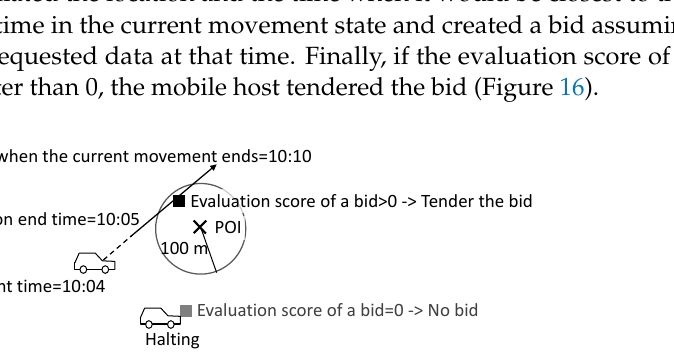
19 of 25 Figure 15. Simulation model for vehicle case (communication and mobility). 5.2.2. Mobility Model Mobile hosts moved by RWP, and they repeatedly stopped for a random period and moved to a randomly selected destination at a randomly selected velocity (Figure 15). The period for which a mobile host stops was selected to be between 0 s and 5.0 s by a uniform random number. The destination of a mobile host was selected by a uniform random num- ber. The density of the mobile hosts within the movement area varied from location to location, even in this scenario [26 – 28]. We used different velocity ranges for the pedestrian and vehicle cases. For the pedestrian case, the host velocity was between 0.1 and 3.0 m/s, as determined by a uniform random number. For the vehicle case, the host velocity was selected to be between 6.0 and 15.0 m/s by a uniform random number.